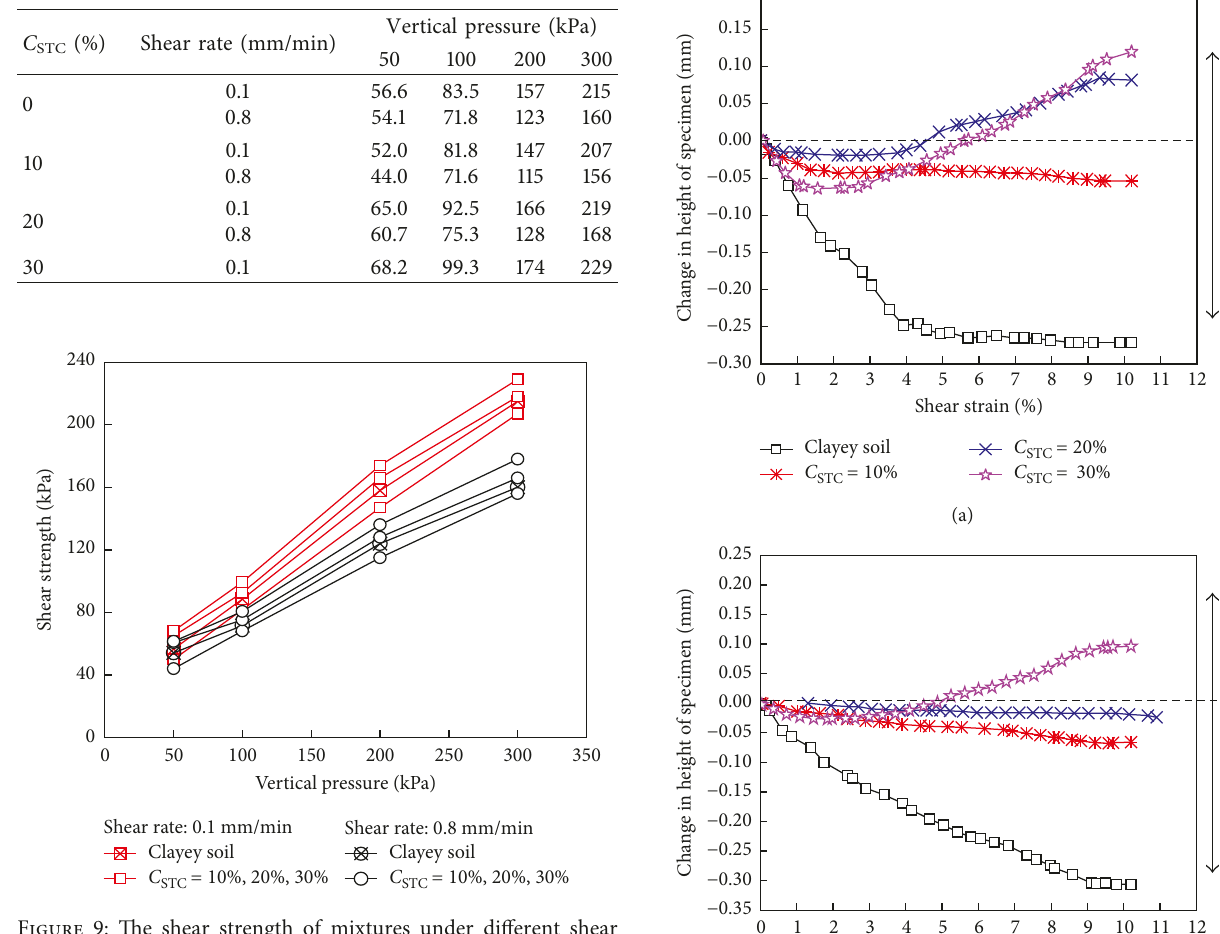
Figure 9: The shear strength of mixtures under different shear rates.